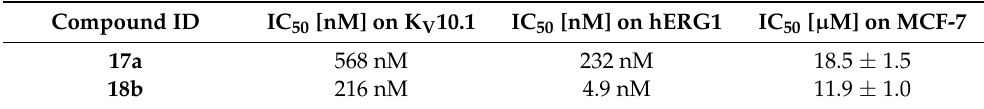
Table 6. IC 50 values for K V 10.1, hERG, and the antiproliferative activities in the MCF-7 breast cancer cell line of the synthesized compounds 17a and 18b